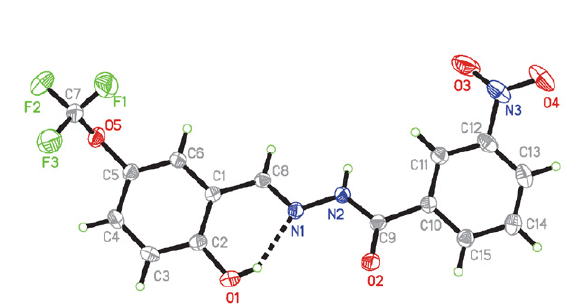
Figure 5. A perspective view of the molecular structure of 5 with the atom labeling scheme. Thermal ellipsoids are drawn at the 30% probability level. Hydrogen bond is shown as a dashed